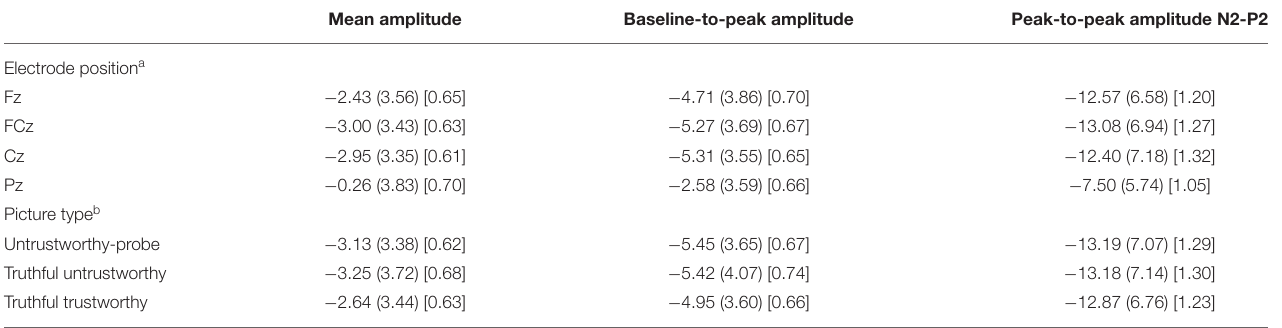
TABLE 2 | N2 amplitudes in microvolt ( µ V) for electrode position and picture type based on different quantifications. Mean amplitude Baseline-to-peak